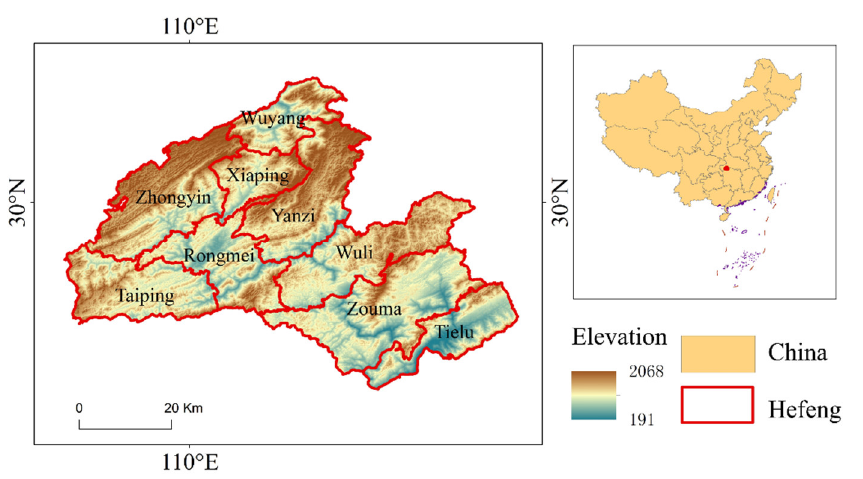
Figure 1. Elevation of Hefeng County, China.